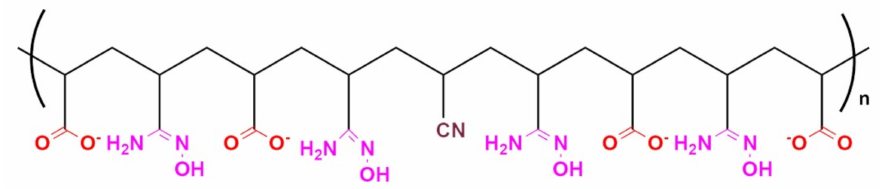
Figure 1. The chemical structure of the amidoxime-carboxylate containing polymer adsorbent derived from acrylic